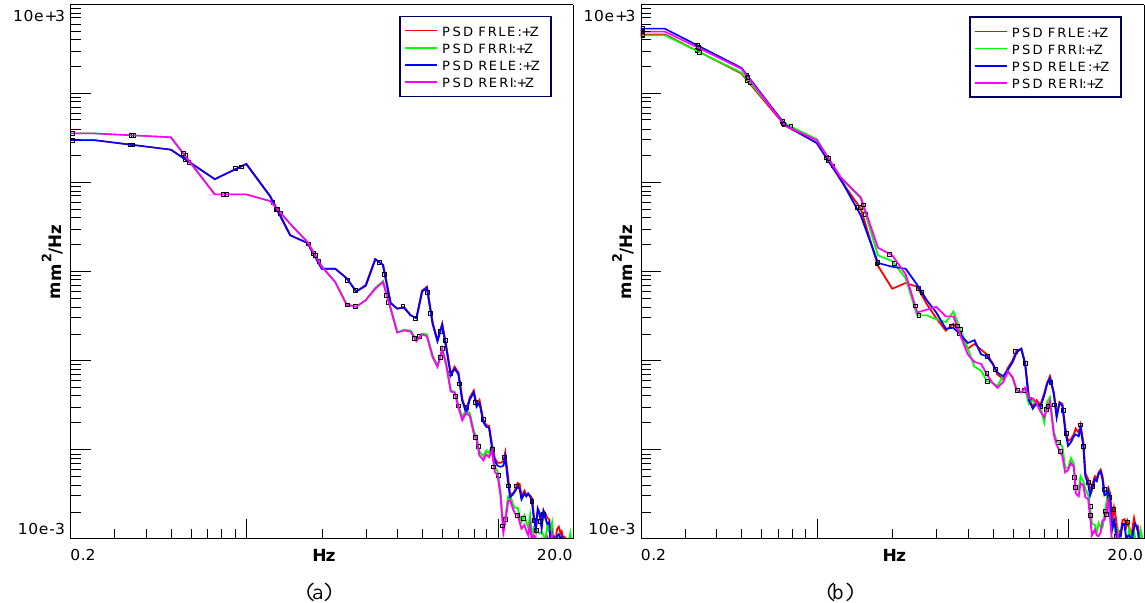
Fig. 3. The road profile roughness PSD of (a) the Blue-kay track (60 km/h) and of (b) the Florida track (80